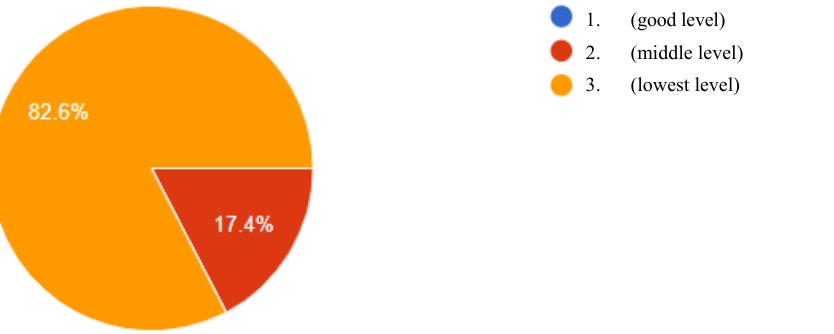
Figure 3. The distribution of the answers about howthe country takescare ofthe environment.